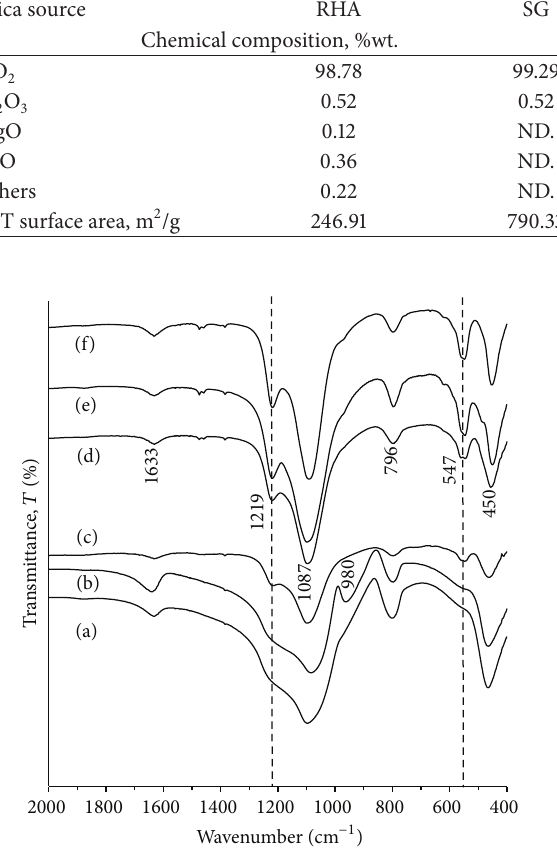
Figure 1: FT-IR spectra of silica source. RHA (a), SG (b), and sili- calite samples: SL1 (c), SL3 (d), SL6 (e), and SL7 (f) with different gel compositions (see Table